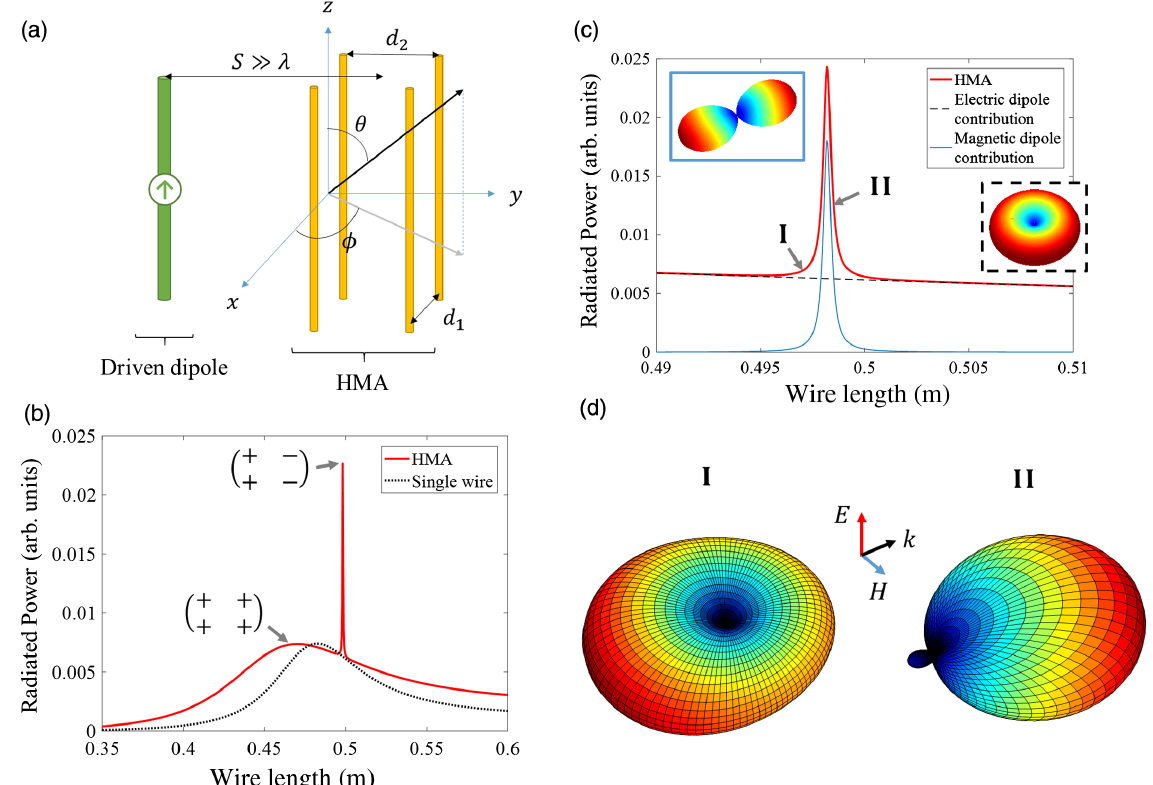
FIG. 2. (a) Sketch of the HMA configuration. Four metallic wires oriented along z are placed at the four corners of a rectangle of sides d 1 . 5 cm and d 2 cm. A fifth wire is used as a source located at a distance S large compared to the wavelength at 297.2 MHz. 1 ¼ 2 ¼ Such a configuration allows us to study the response of the HMA with a plane wave excitation. All wires have a diameter of 2 mm. (b) Radiated power from the HMA (solid red line) as a function of the wire length (excitation frequency 297.2 MHz is kept constant) is compared with the power radiated by a single wire (dashed black line) of the same varying length. The inset shows the phase of the current within the four wires of the HMA. This is evidence of the hybridization mechanism leading to a broad dipolar electric resonance and a sharp magnetic dipolar resonance. (c) Radiated power from the HMA on a narrow window (solid red line). Dashed black line and solid thin blue line show the isolated contributions of the two resonances excited in the HMA. The two insets show the radiation pattern of the magnetic dipolar resonance and the electric dipolar resonance. (d) Far-field radiation pattern at the two Kerker conditions (HMA lengths denoted above). The first one presents a reduction of the forward scattered field while a cancellation of the backward scattered field is observed at the second